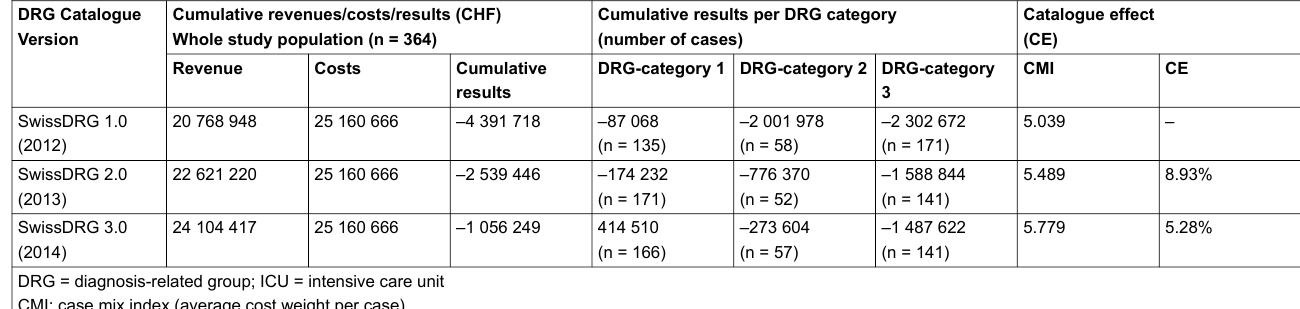
Table 4: Cumulative revenue, costs and financial results according to SwissDRG versions 1.0, 2.0 and 3.0, including supplementary payments, as well as catalogue effects for the whole study group and DRG categories. A base rate of 11300 CHF was assumed (n = 364). Results per case are given as mean (standard deviation). The CMI is given in case mix points.